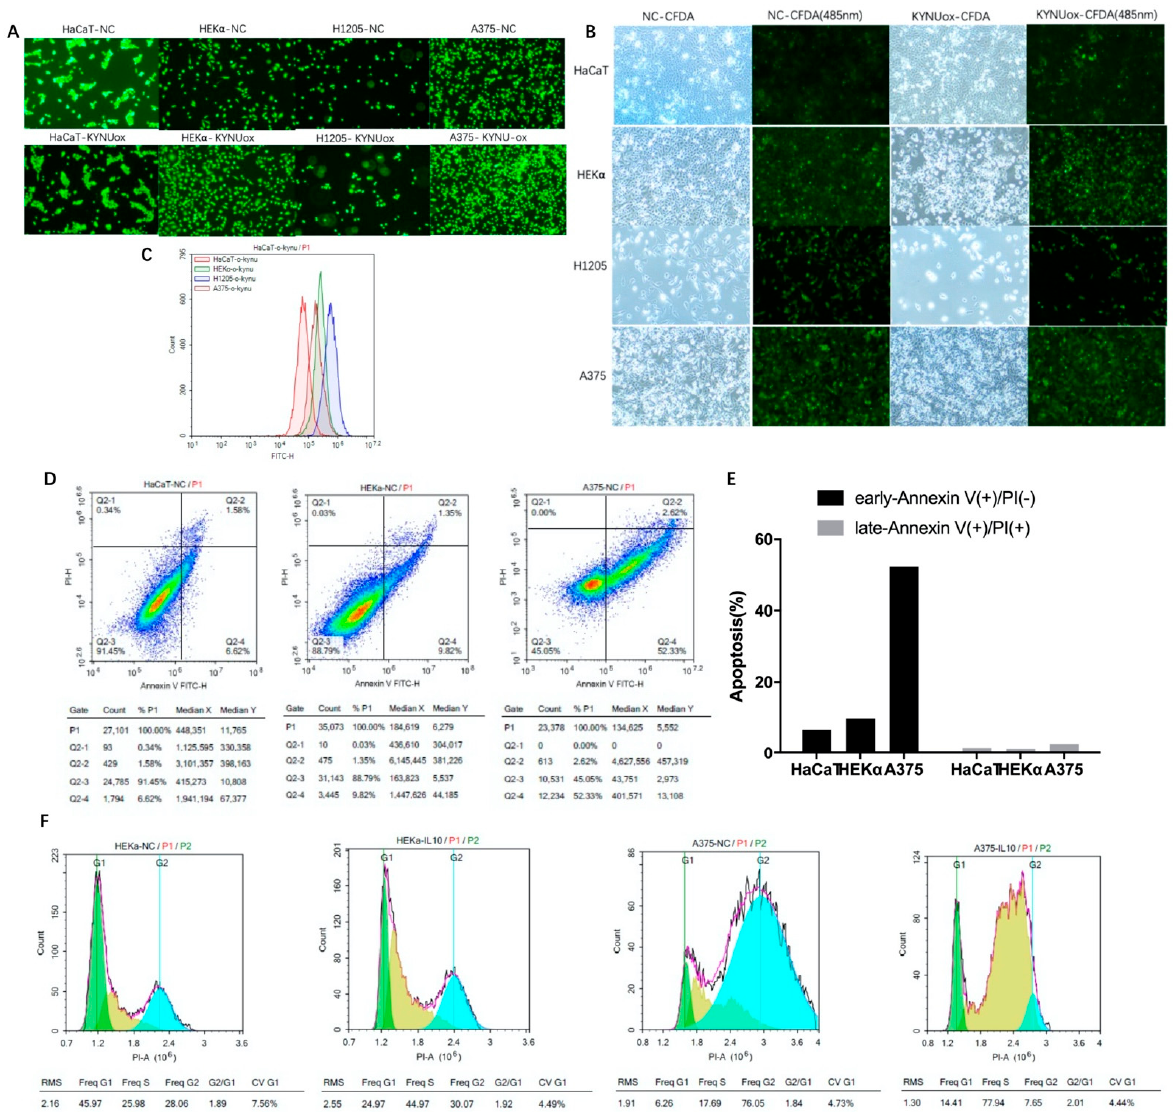
Figure 5. Effects of KYNU overexpression on proliferation and apoptosis of melanoma cells or keratinocytes and the effects on melanoma cell cycle of IL-10 and IFN- γ : ( A – C ) cells were stained with CFDA-SE after 8 h of adherence and continued to culture for 62 h. Immunofluorescence and flow cytometry were used to detect changes in the peak fluorescence of cells; ( D , E ) apoptosis flow analysis of Annexin V–PI double staining in keratinocytes and melanoma cell lines; ( F ) PI single-stained cell-cycle flow analysis in normal and IL-10-stimulated HEK α and A375 cells.